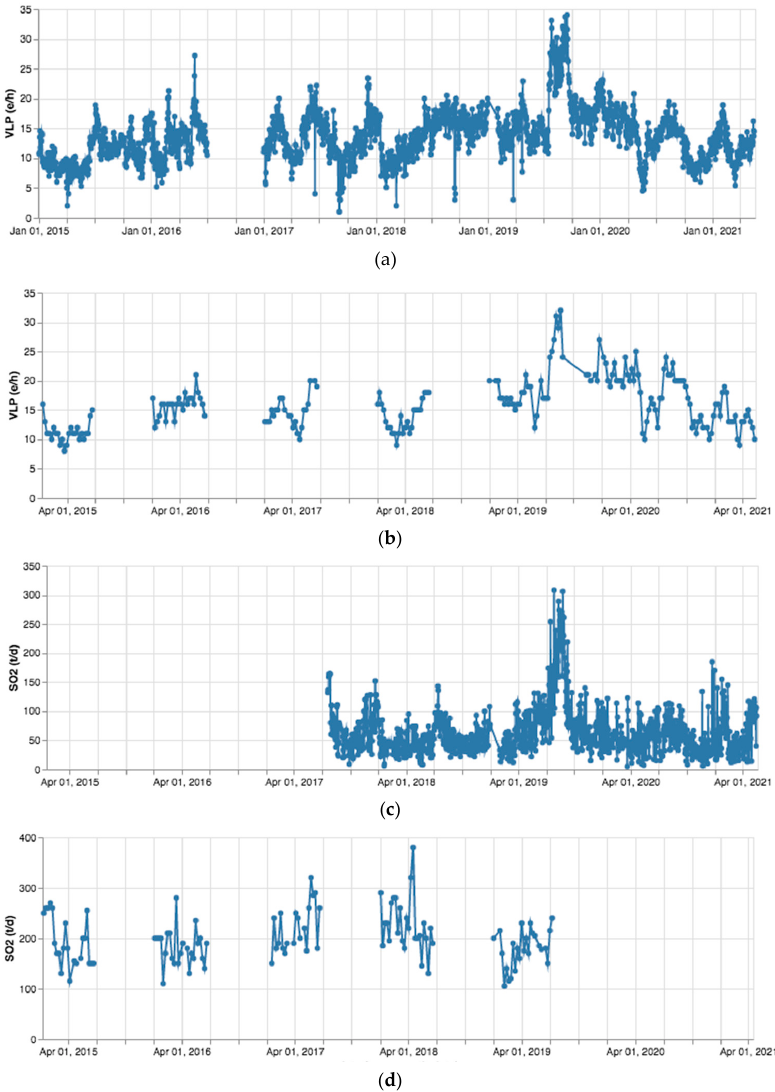
Figure 6. ( a ) LGS, VLP parameter (events/h); ( b ) INGV, VLP parameter (events/h); ( c ) LGS, SO 2 parameter (tons/day); ( d ) INGV, SO 2 parameter (tons/day).